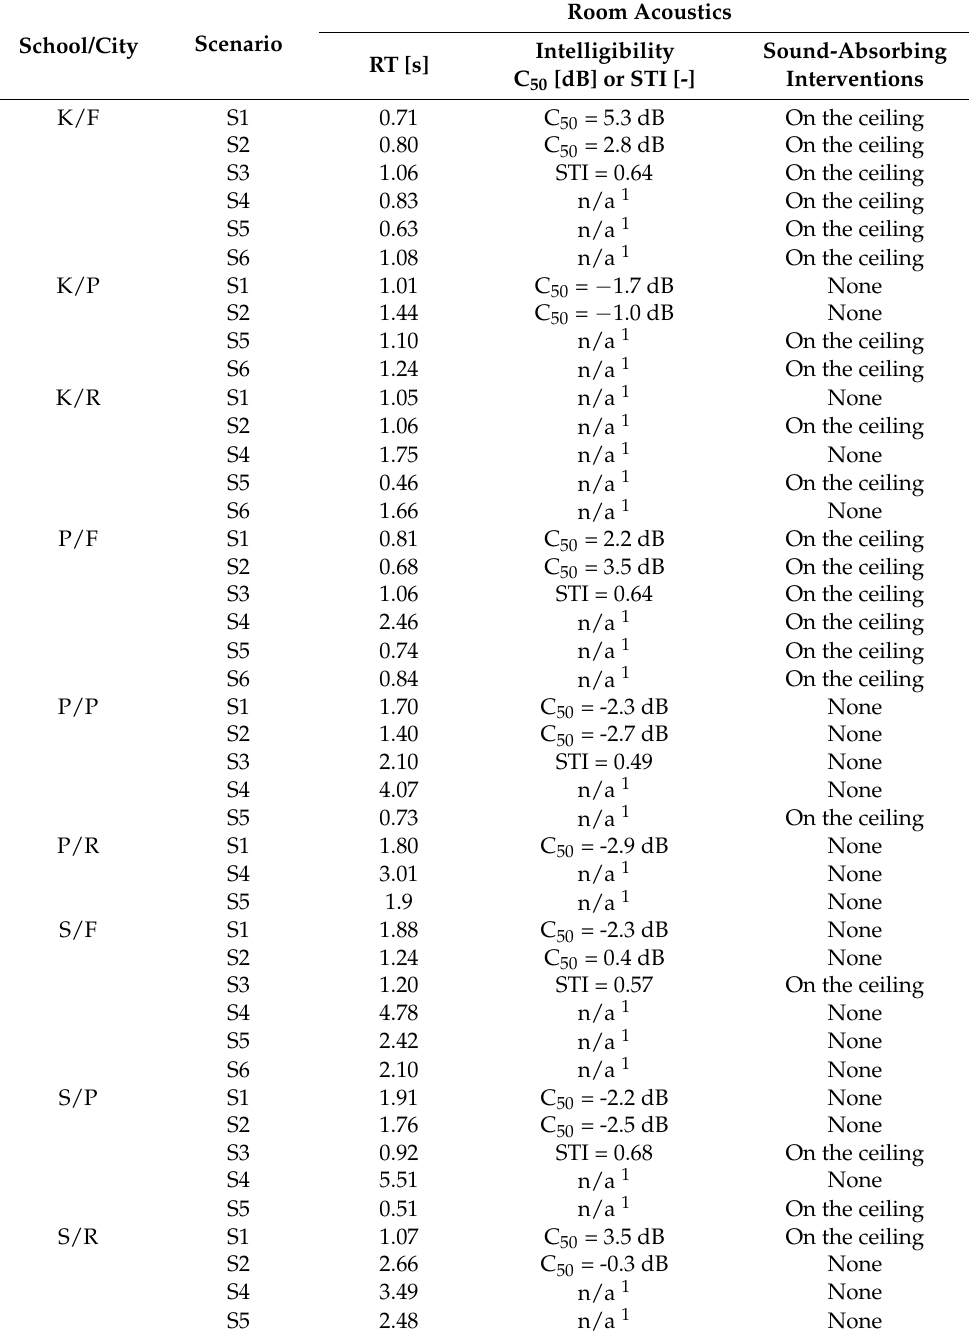
Table 3. Room acoustics results and sound-absorbing interventions in the case study schools. RT and C 50 are the mean values of octave bands between 250 Hz and 2000